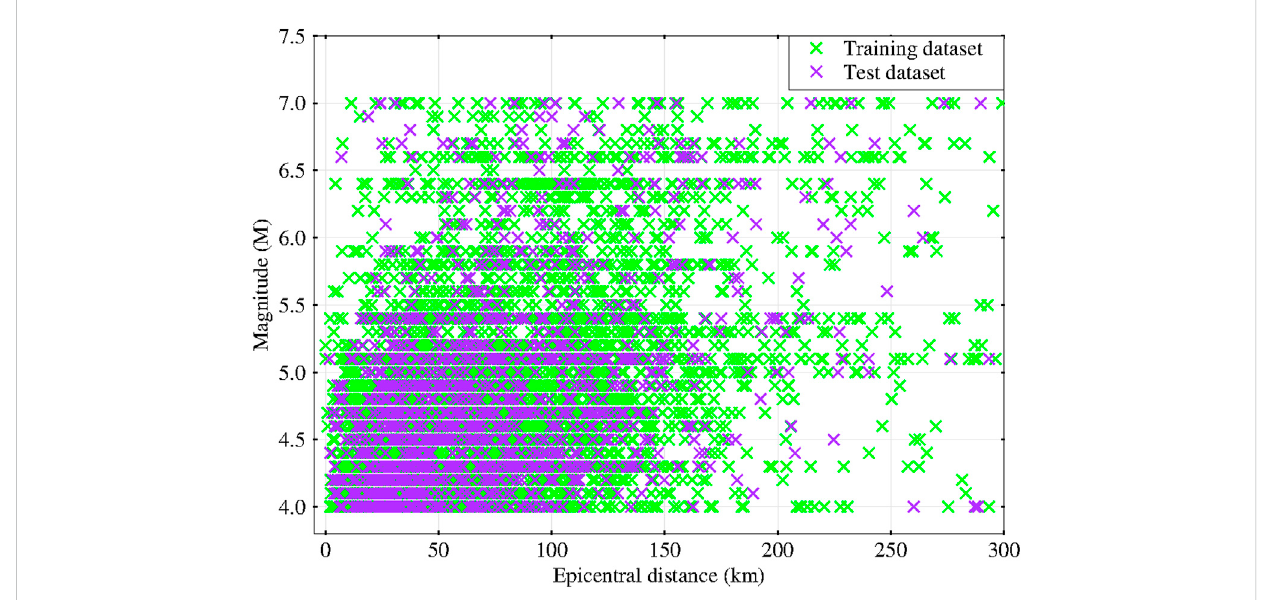
FIGURE 2 Therelationshipbetweenthemagnitudeandepicentraldistance.Thegreencrossesrepresentthetrainingdataset,andthepurplecrossesrepresent the test